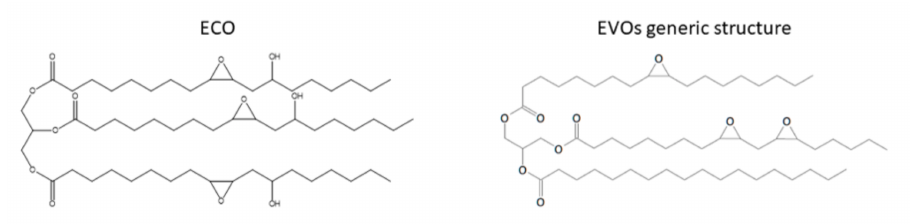
Figure 5. ECO structure and generic EVOs